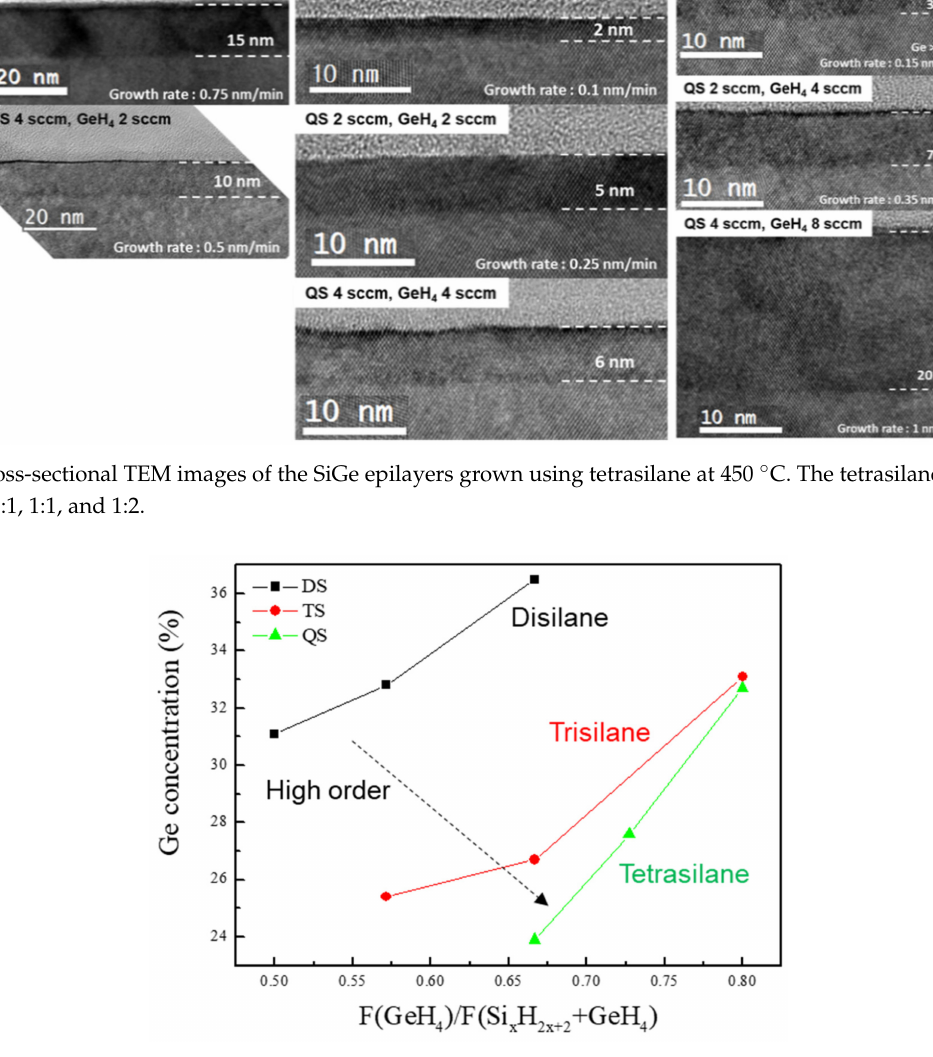
Figure 9. Ge concentration of the SiGe epilayers as a proportion of the Ge flow